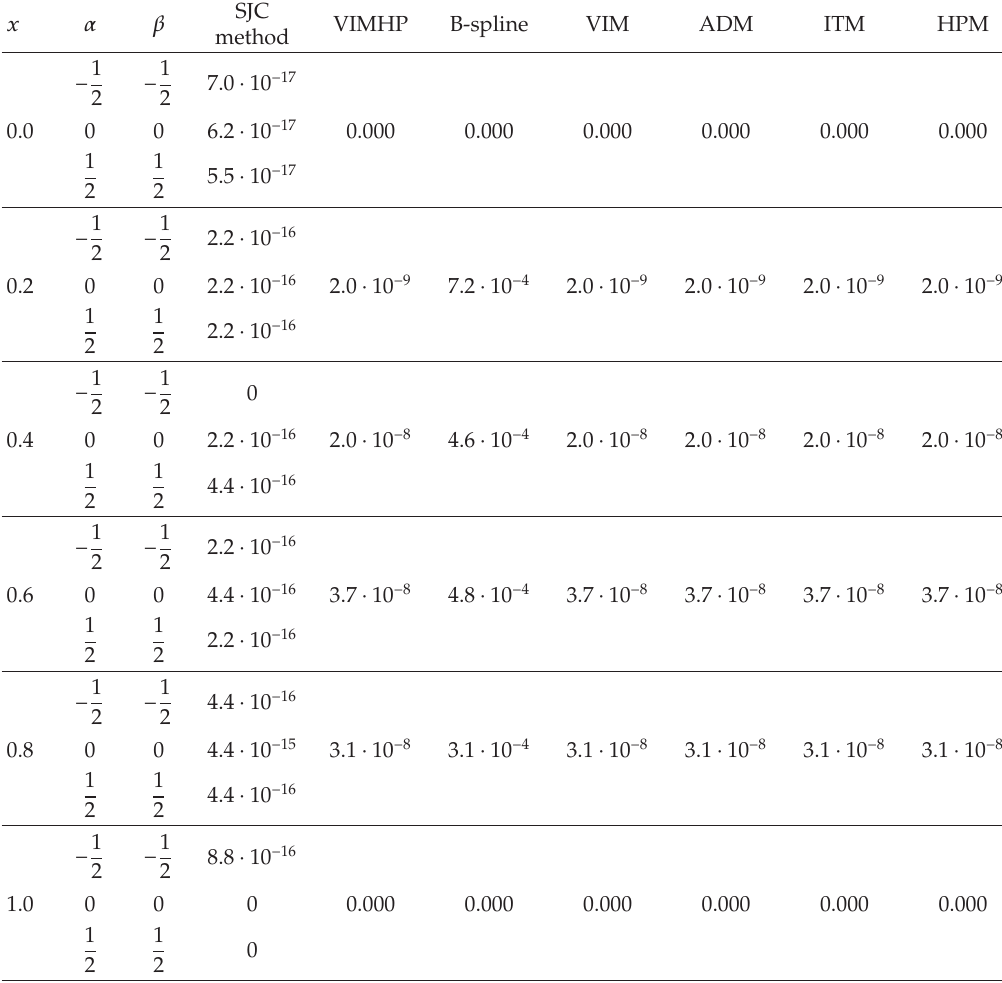
Table 2: Absolute errors using SJC method for N (cid:8) 14.